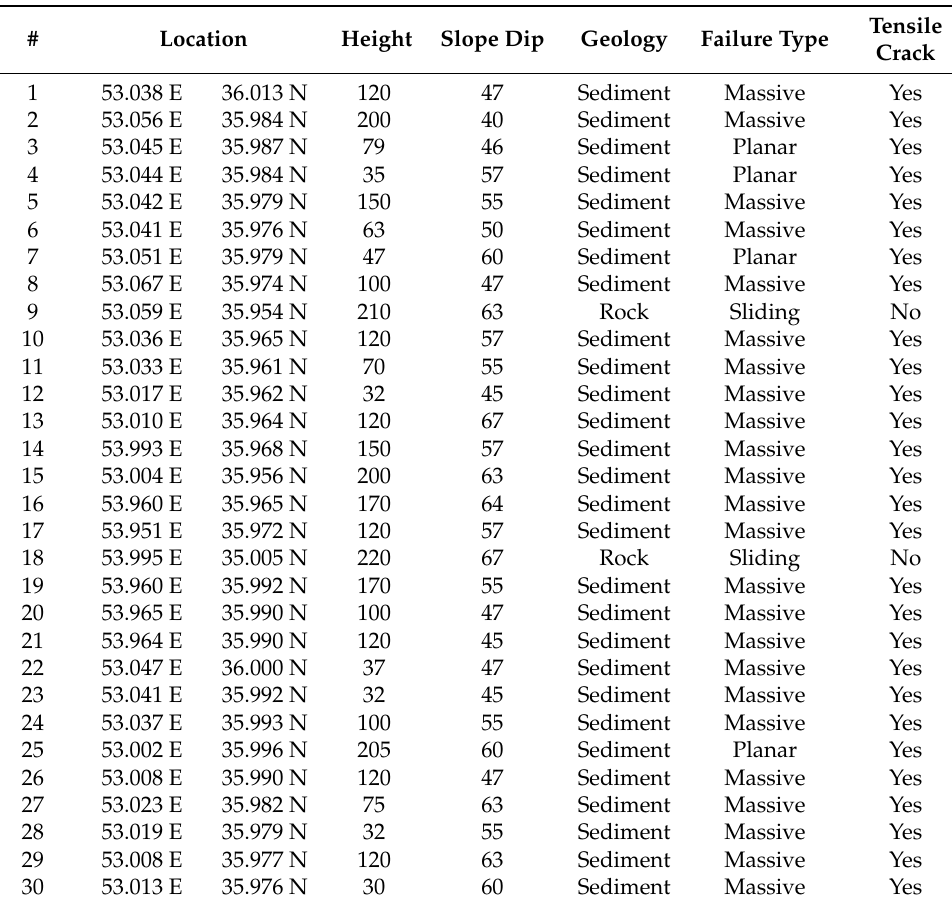
Table 2. A summary of the historical